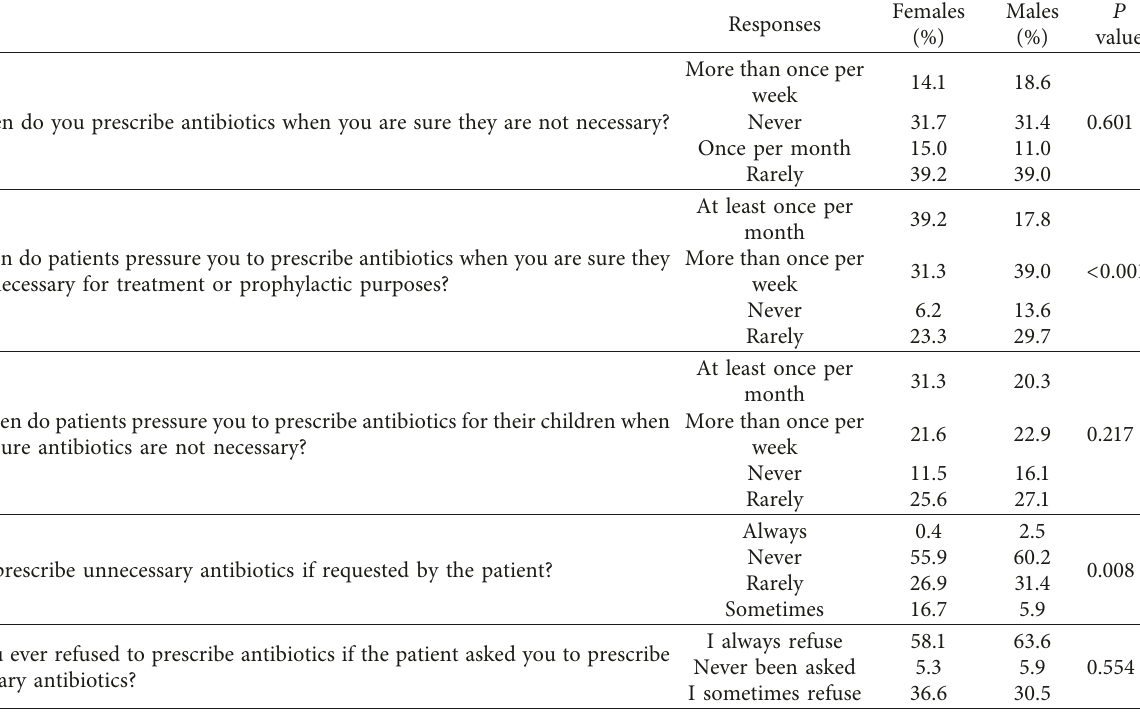
Table 2: Unnecessary antibiotic prescribing by gender.